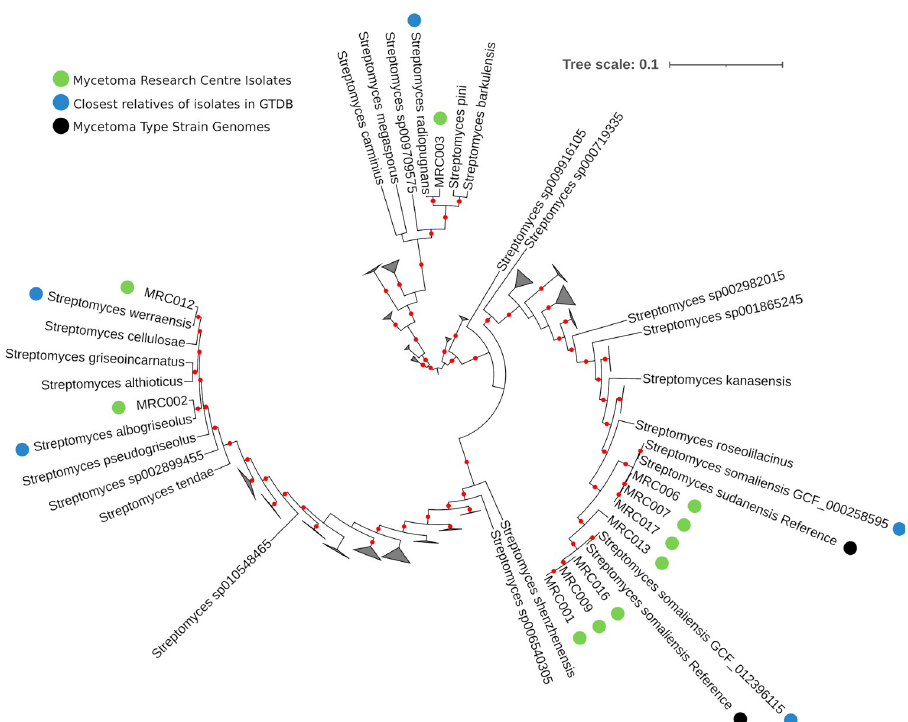
Fig 3. Tree of single copy orthologs belonging to the GTDB bac120 dataset, from the genomes of Streptomyces related isolates from the Mycetoma Research Centre (green), their relatives according to ANI in GTDB (with the closest relatives indicated in blue) and genomes from type strains of species typically associated with actinomycetoma (black). A red dot on branches indicates ultrafast bootstrap support > 95. Triangles are used to represent collapsed clades. The tree was inferred in iqtree2 using the C20 model. The full figure is available at https://itol.embl.de/shared/ 1MX60mtB0Ohk3.